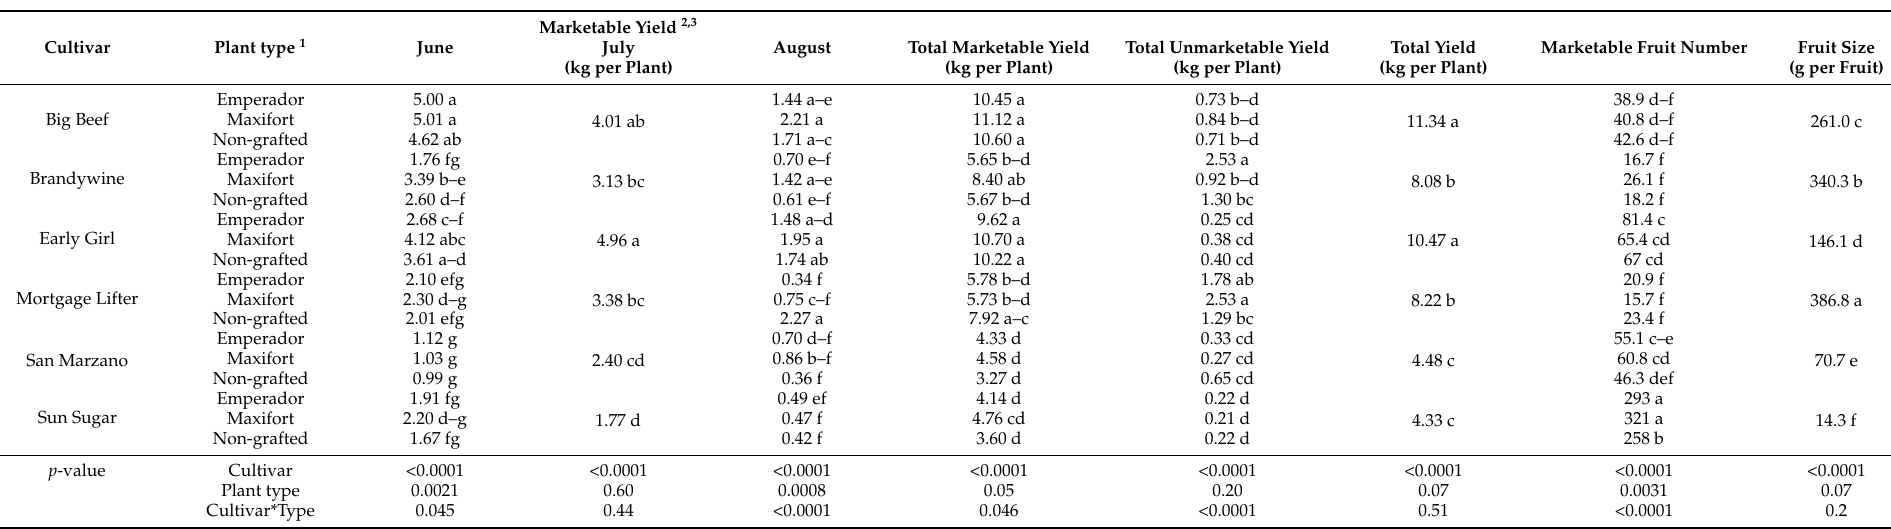
Table 3. Yield components and fruit size of six tomato cultivars when grafted onto two types of rootstocks or grown non-grafted in a high tunnel in